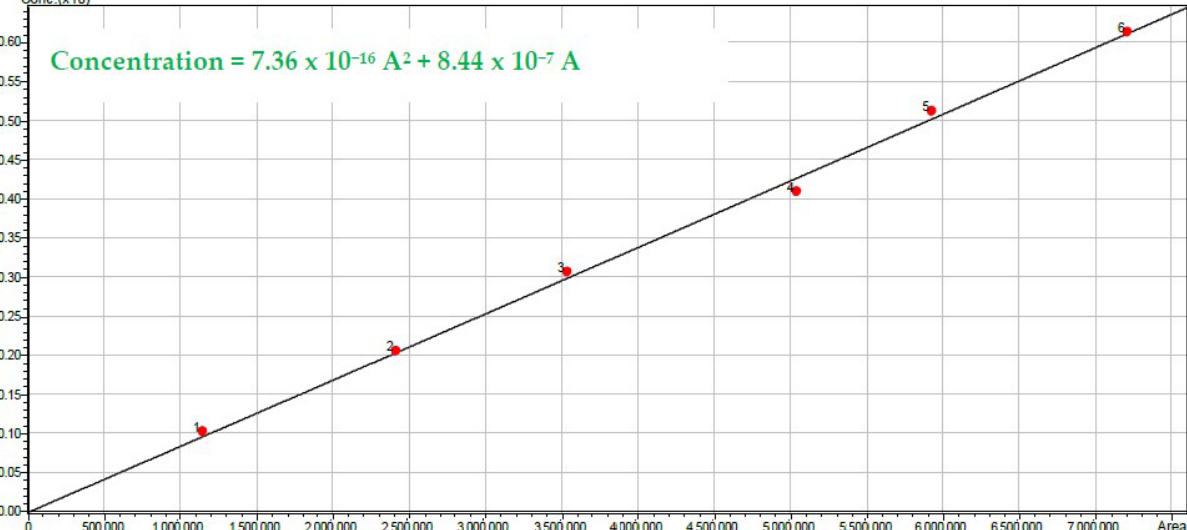
Figure A2. Carbon containing product species peaks as detected by the FID for: ( a ) carbon monoxide (CO), ( b ) methane (CH 4 ), ( c ) carbon dioxide (CO 2 ), ( d ) ethylene (C 2 H 4 ), ( e ) ethane (C 2 H 6 ), ( f ) acetaldehyde (C 2 H 4 O), and ( g ) ethanol (C 2 H 5 OH). H 2 peak measurements were quantified using the TCD calibration, as reported in Figure A3. Calibration was established by using a H 2 certified standard gas mixture sam- ple (10% H 2 and 90% He Praxair), and different known hydrogen volumes (0.1, 0.2, 0.3, 0.4, 0.5, and 0.6 mL). Sample volumes in the syringe were at room temperature, and pres- sure conditions (25 °C and 1 atm).